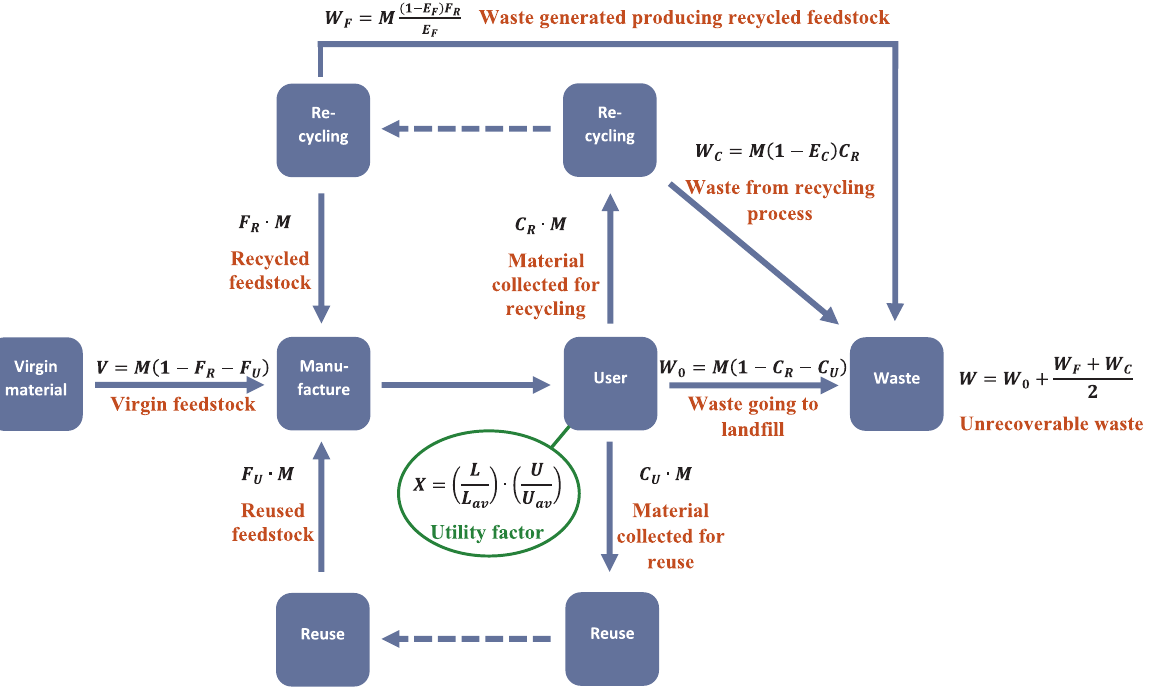
Fig. 1. Schematic representation of material fl ows